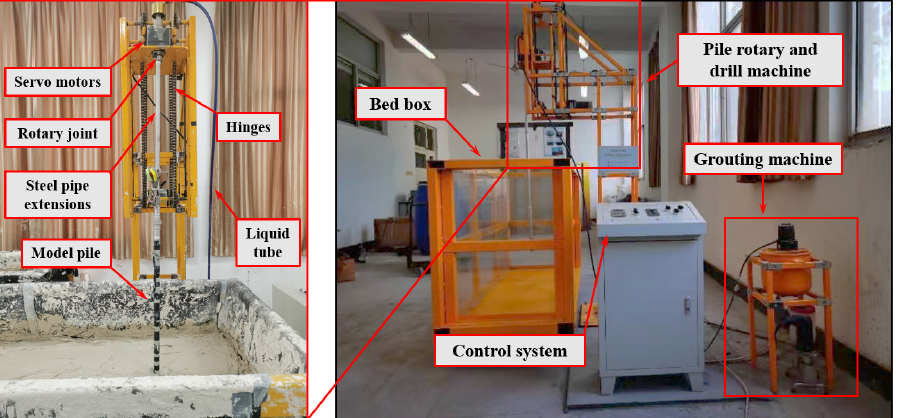
Figure 6. Installation machine of small-scale model piles and the bed